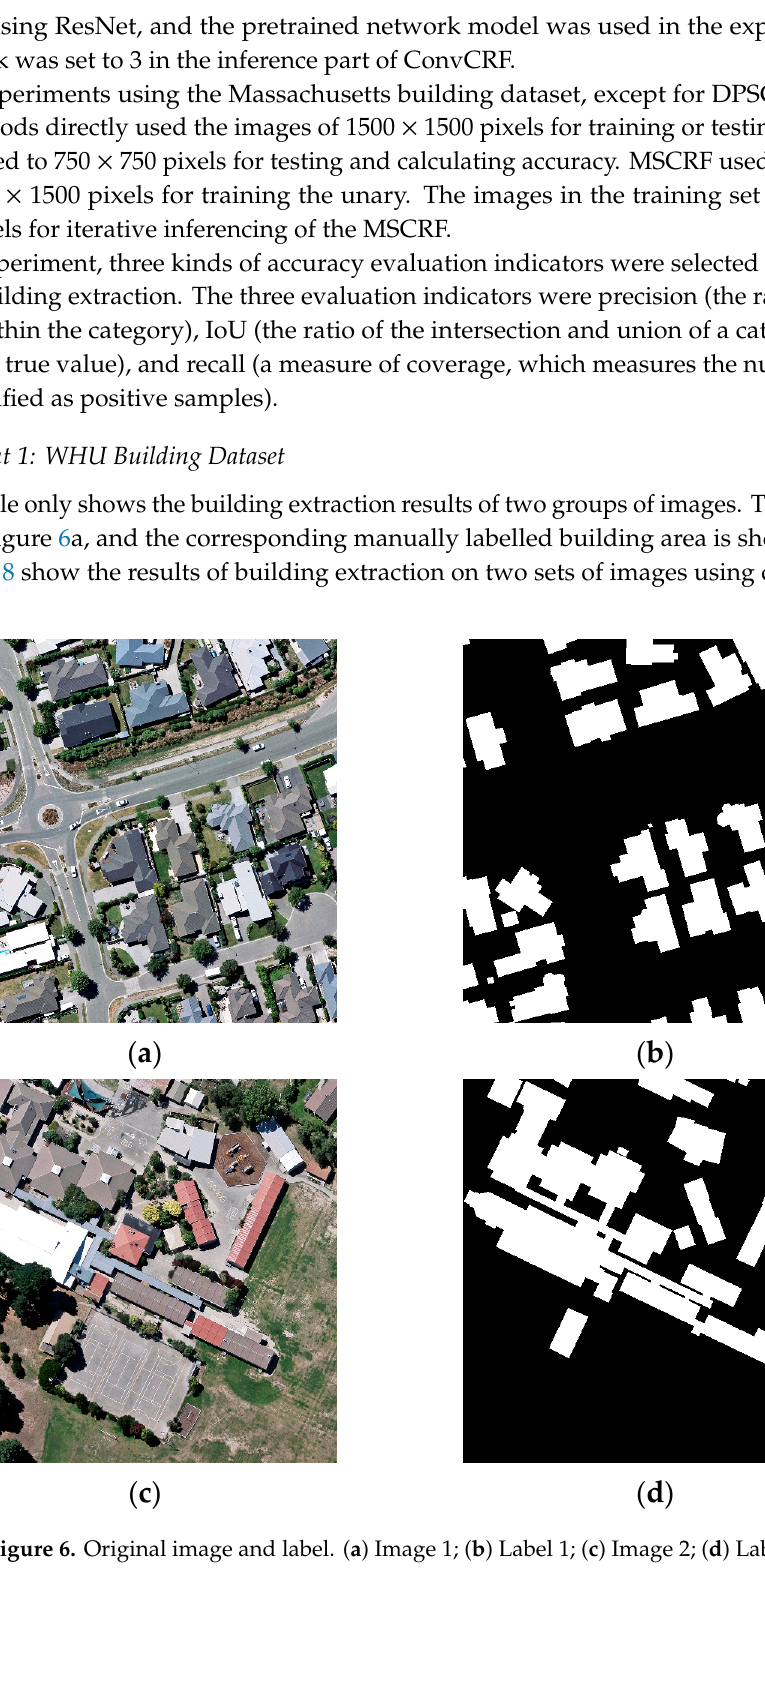
( f ) Figure 7. The building extraction results of image 1. ( a ) Label; ( b ) DPSCRF; ( c ) FullCRF; ( d ) ConvCRF. ( e ) D ‐ LinkNet; ( f ) MSCRF.